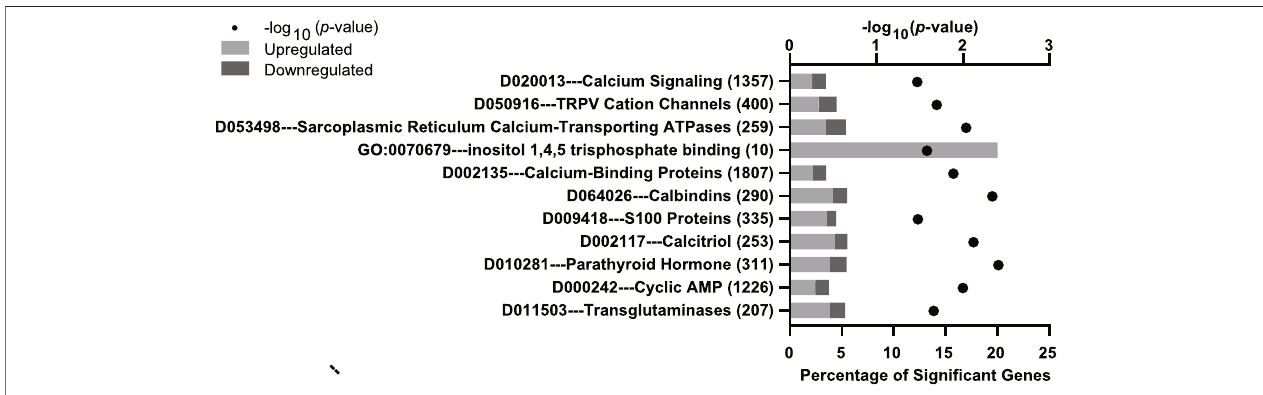
FIGURE 3 | Signi fi cantly enriched calcium traf fi cking pathways from Gene Ontology (GO), Kyoto Encyclopedia of Genes and Genomes (KEGG), and Medical Subject headings (MeSH) pathway analyses in the mammary gland of mice treated with fl uoxetine (20 mg/kg/d, n = 8) or saline control ( n = 8) from embryonic day 13 through lactation day 10. The y-axis denotes the names and total number of genes in each pathway, and the lower x-axis denotes the percentage of signi fi cant genes within each pathway. The upper x-axis denotes the − log 10 p -value. Light gray bars indicate upregulated DEGs and dark gray bars indicate downregulated DEGs within each pathway.